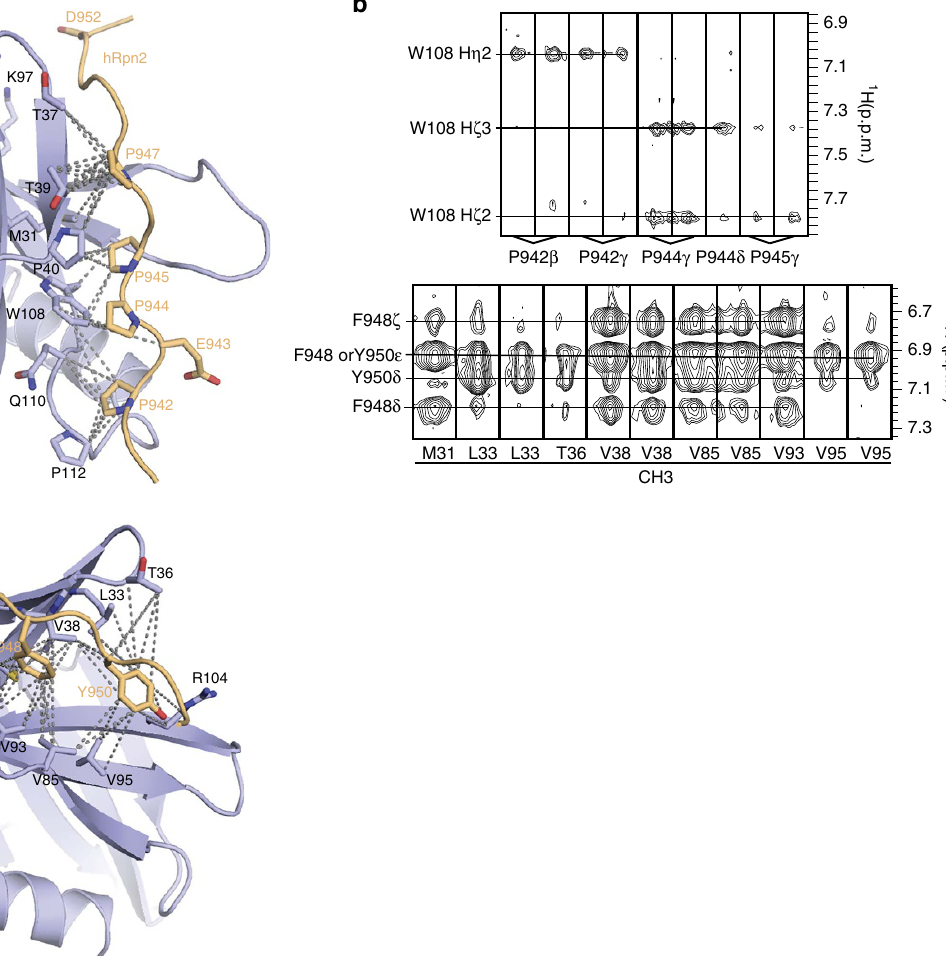
Figure 2 | hRpn2 zippers along an hRpn13 surface with extensive interactions and a proline-rich contact surface. ( a , c ) Ribbon diagram of hRpn13 (periwinkle blue) with heavy atoms at the hRpn2 contact surface displayed. All hRpn2 heavy atoms are shown (light orange) with dashed lines representing intermolecular NOE interactions involving ( a ) hRpn2 P942-P945 and P947 and ( c ) hRpn2 F948 and Y950. Nitrogen, oxygen and sulfur side-chain atoms are displayed in blue, red and yellow, respectively. The orientation in ( a ) is selected to highlight interactions involving hRpn13 W108. ( b ) Selected intermolecular NOEs between hRpn2 and hRpn13. Selected regions from a 1 H, 13 C edited NOESYexperiment acquired with 0.7mM 15 N, 13 C-labelled hRpn2 (940–953) and equimolar unlabelled hRpn13 Pru (upper panel) and selected regions from a 1 H, 13 C half-filtered NOESYexperiment acquired with 0.7mM 15 N, 13 C-labelled hRpn13 Pru and equimolar unlabelled hRpn2 (940–953) (lower